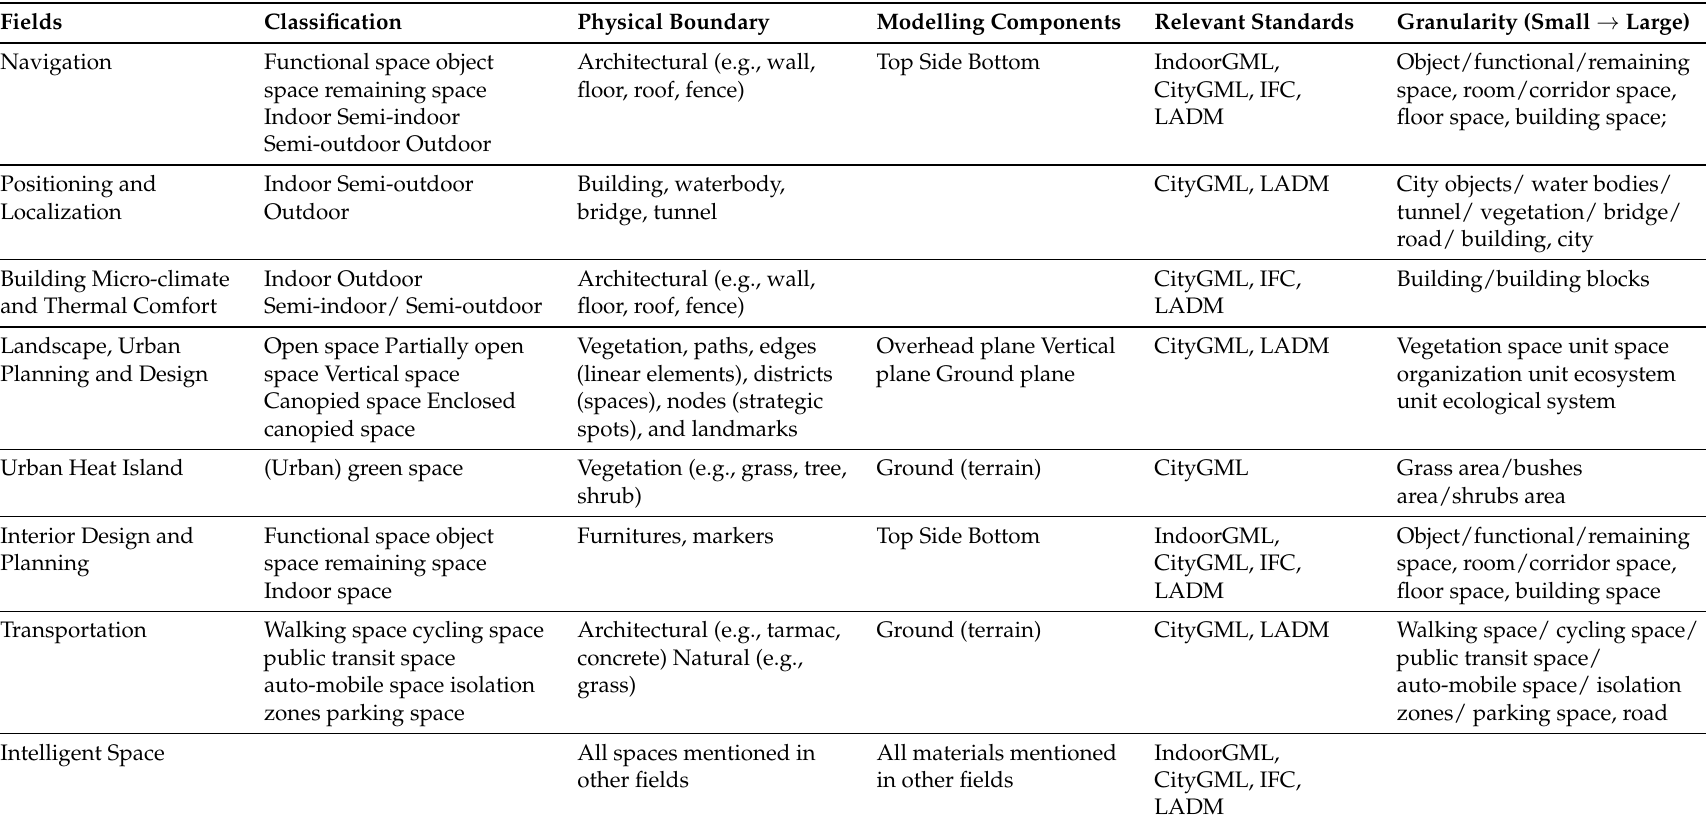
Table 3. Space comparisons in different